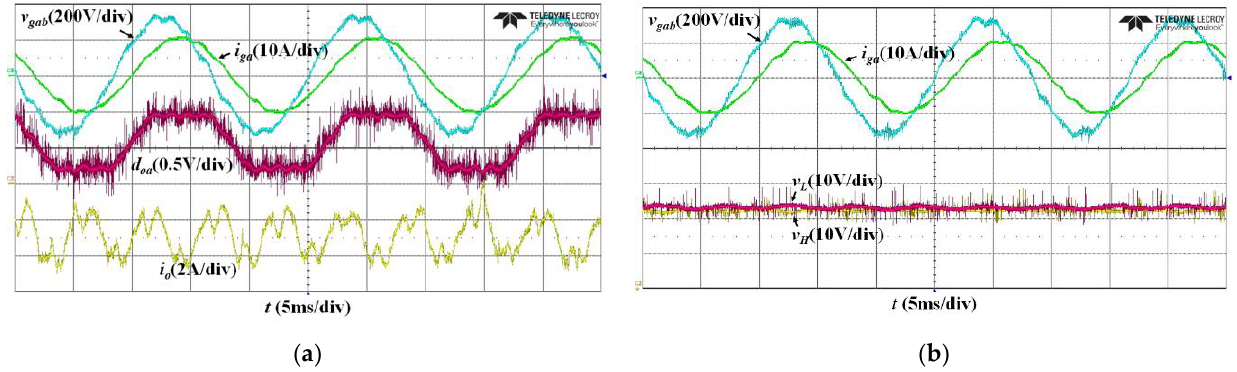
Figure 10. Experimental waveforms under unbalanced load condition corresponding to 40% deviation of output power. ( a )